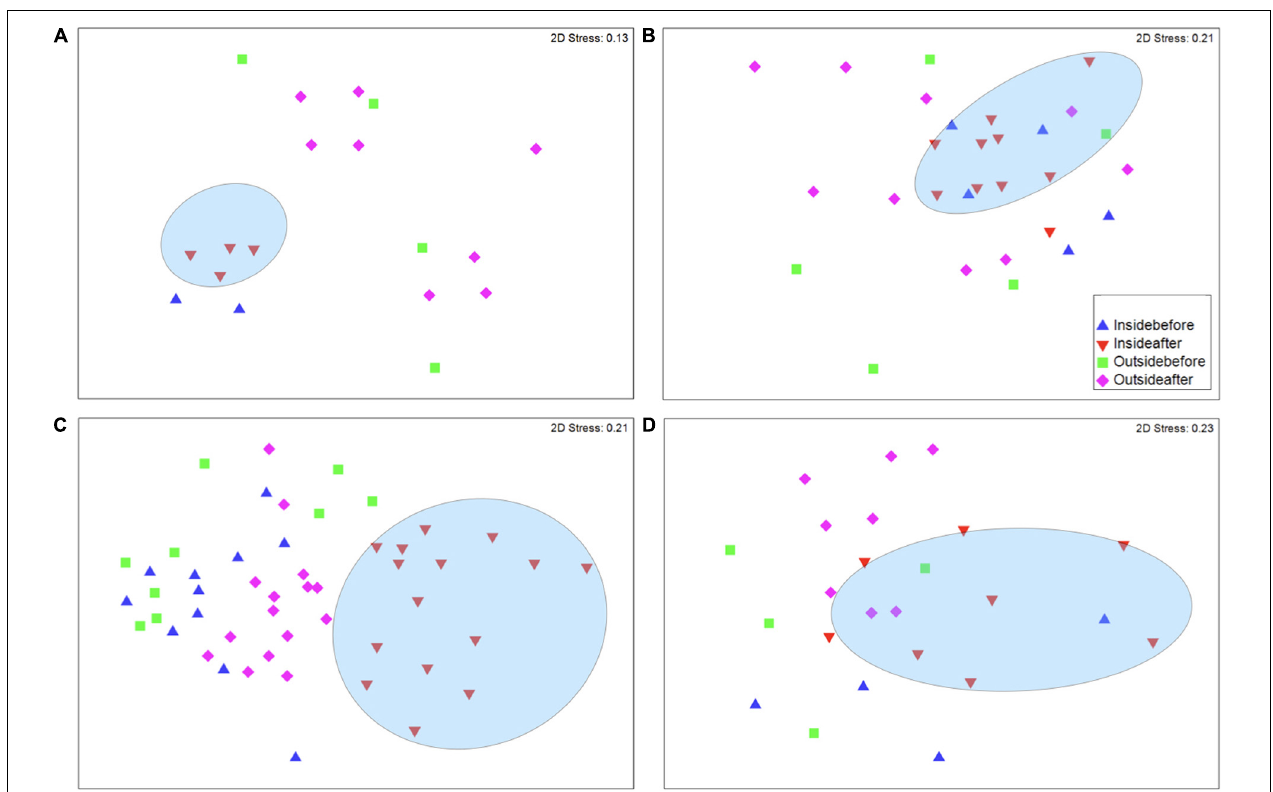
FIGURE 7 | Non-metric multidimensional scaling of community structure similarities for (A) Culasi, (B) Manjuyod, (C) Gubat, and (D) Tayasan. Triangles denote the community structure inside marine reserve and squares and diamonds outside of marine reserves. Triangles denote the community structure inside marine reserve (blue indicates before and red indicates after CBM implementation), and squares and diamonds outside of marine reserves, with squares indicating before, and diamonds indicating after CBM implementation. The ellipses indicate significant clusters ( P <